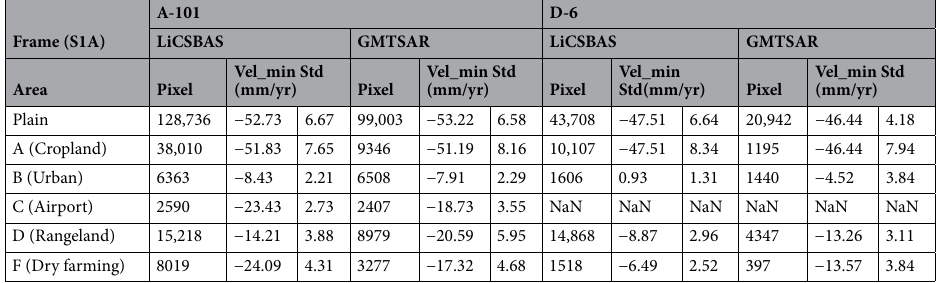
Table 2. Information generated for displacement velocity maps due to subsidence at the